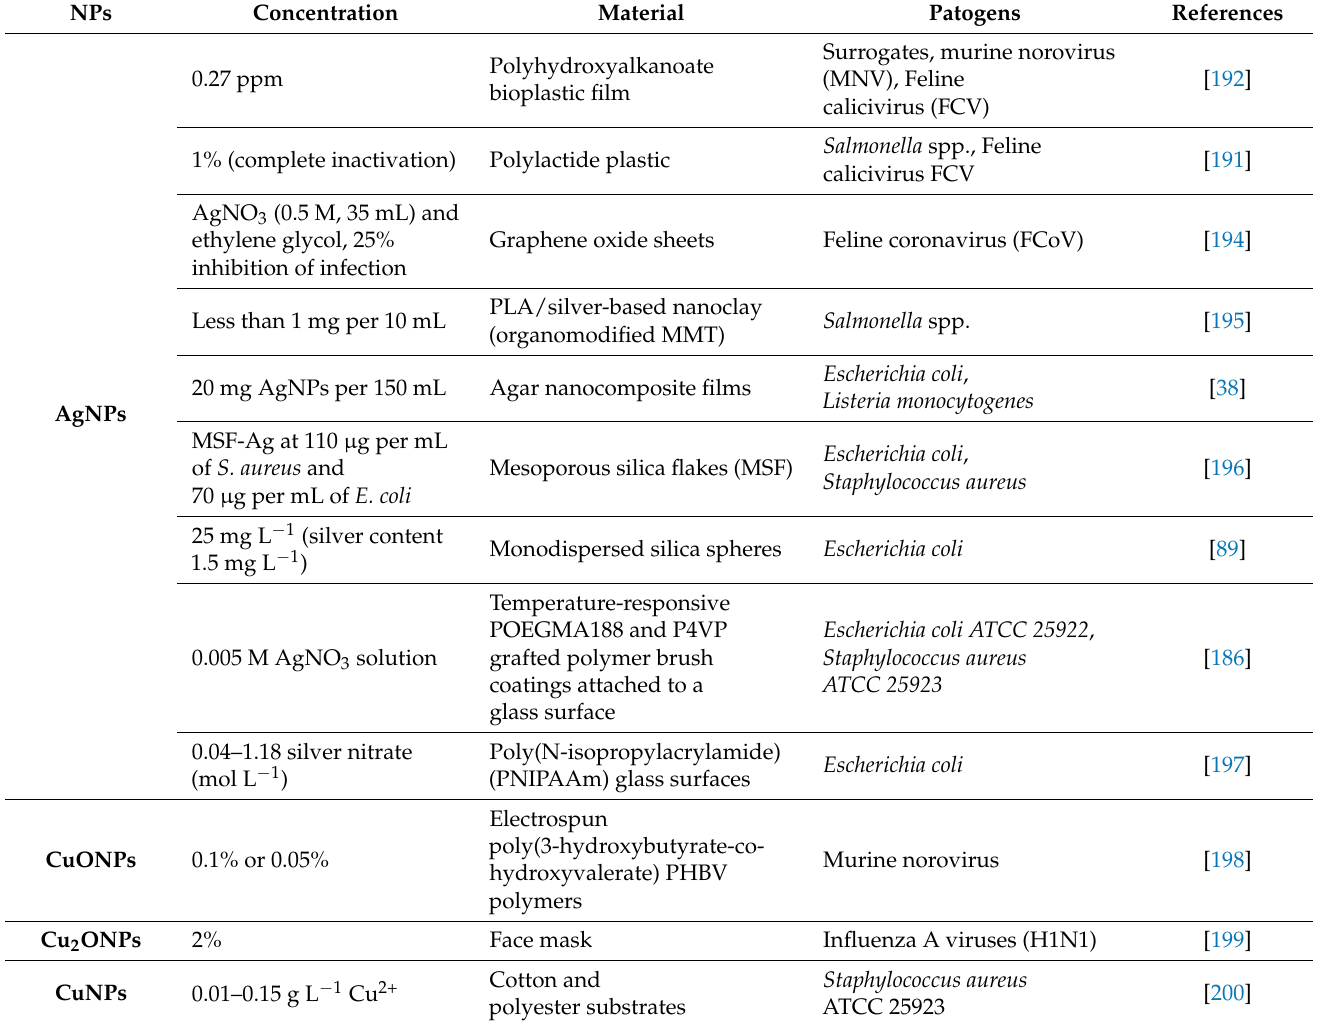
Table 3. Application of silver and copper nanoparticles for production of self-sterilizing